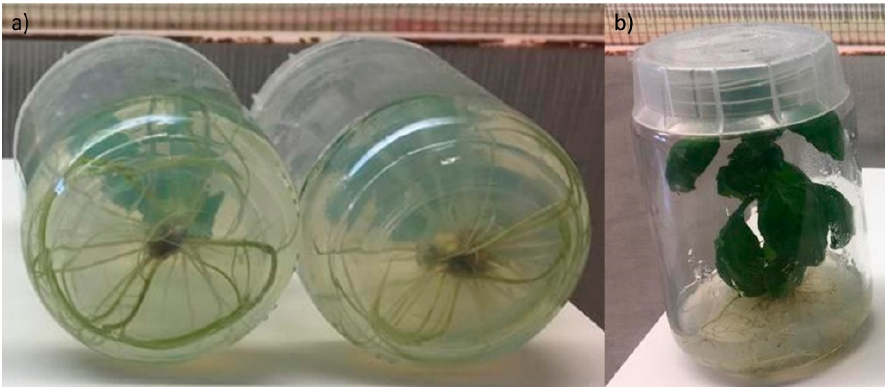
Figure 3. Ocimum basilicum FT Italiko: ( a ) rooting phase of regenerated plants onto MSS PGR-free; ( b ) example of singularized and rooted plants onto MSS PGR-free (MSS = shoot multiplication medium